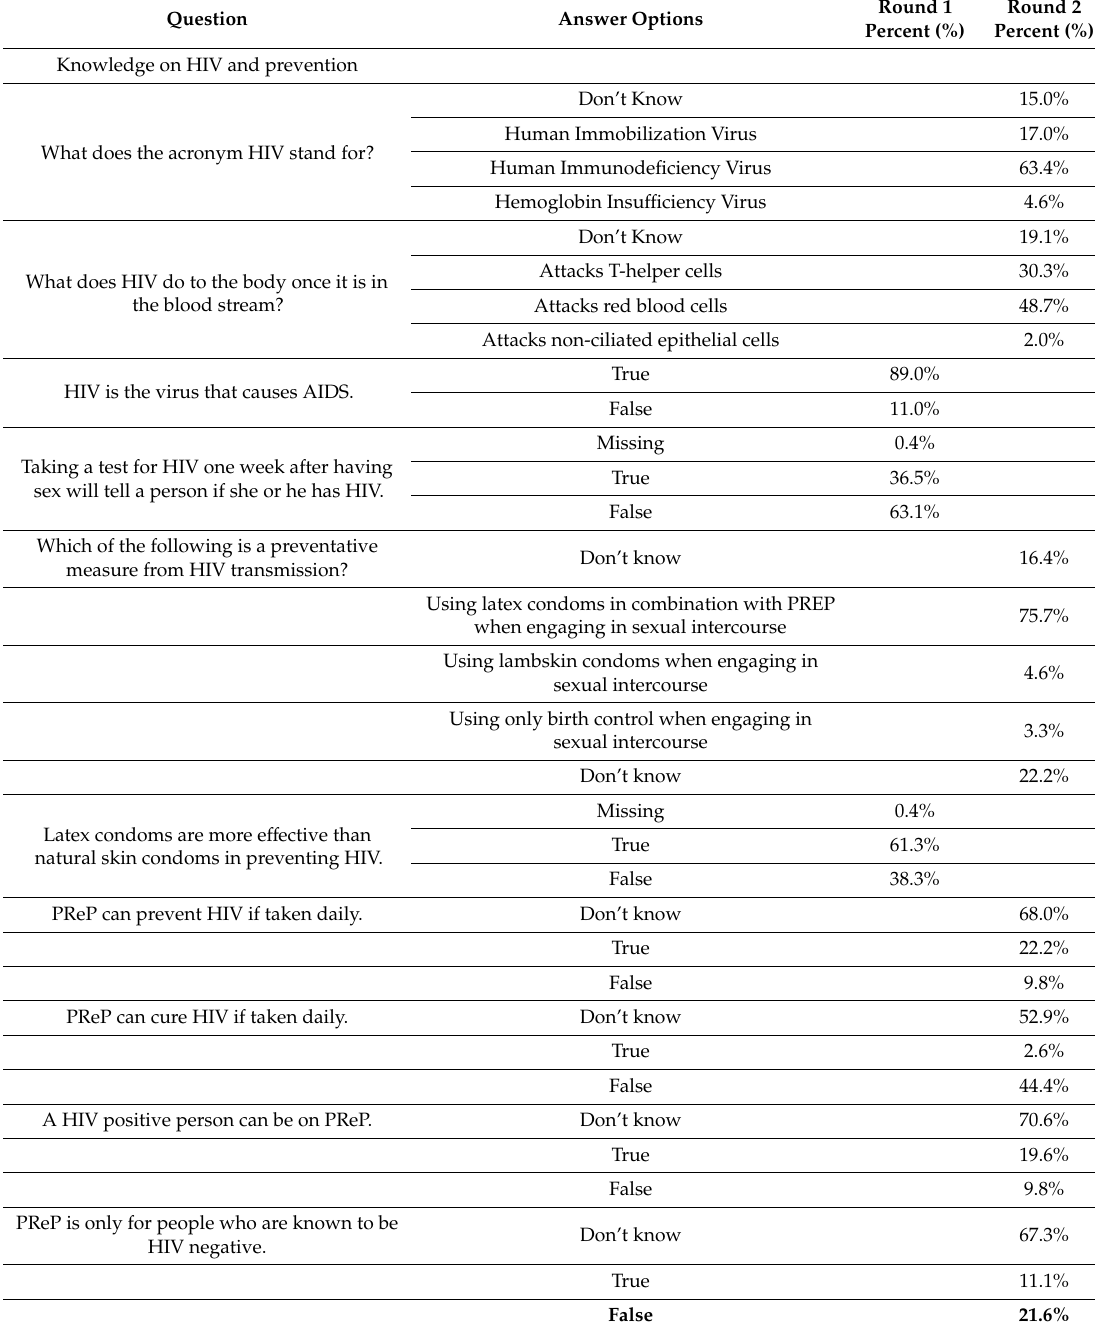
Table 1. HIV knowledge among college students (n =